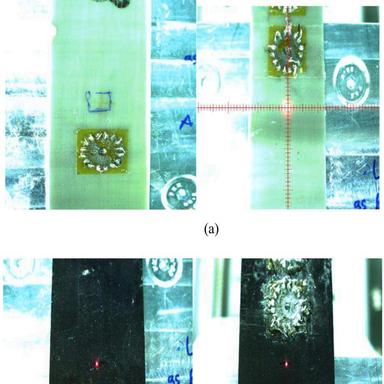
Photographs detailing the lateral positions of measurements conducted using ED-XRD (marked with red points) and IHD for (a) GFRP/steel/GFRP and (b) CFRP/steel/CFRP samples. (For interpretation of the references to colour in this figure legend, the reader is referred to the web version of this article.)